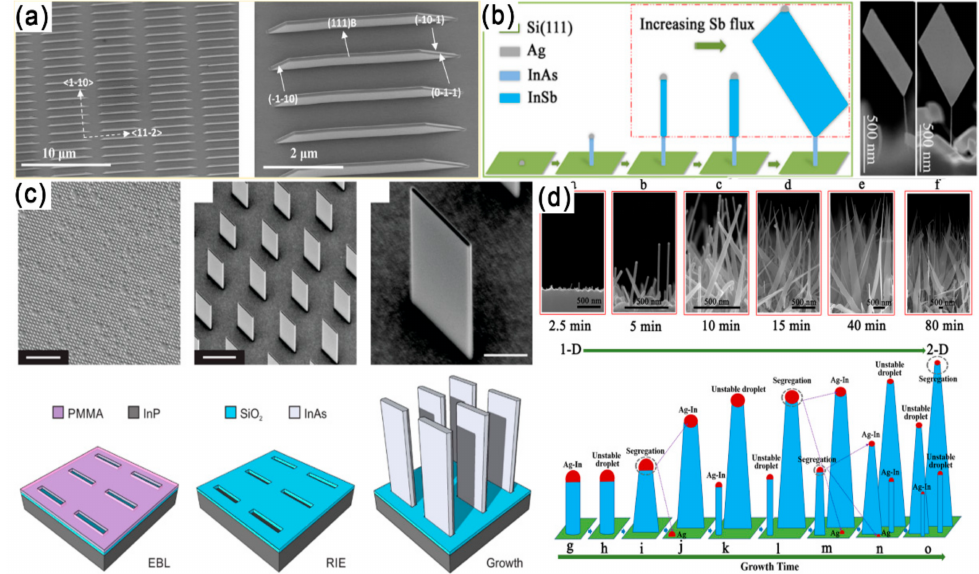
Figure 5. ( a ) Macroscopic SEM image of nanosheet arrays and a single nanosheet. The inclined surfaces of the nanosheets are three {110} planes [61]. Copyright 2013, American Chemical Society. ( b ) Diagram of the growth process and SEM images of the InSb nanosheets. Reproduced with permission [62]. Copyright 2016, American Chemical Society. ( c ) Templated growth of 2D InAs nanofin structures. Reproduced with permission [63]. Copyright 2019, American Chemical